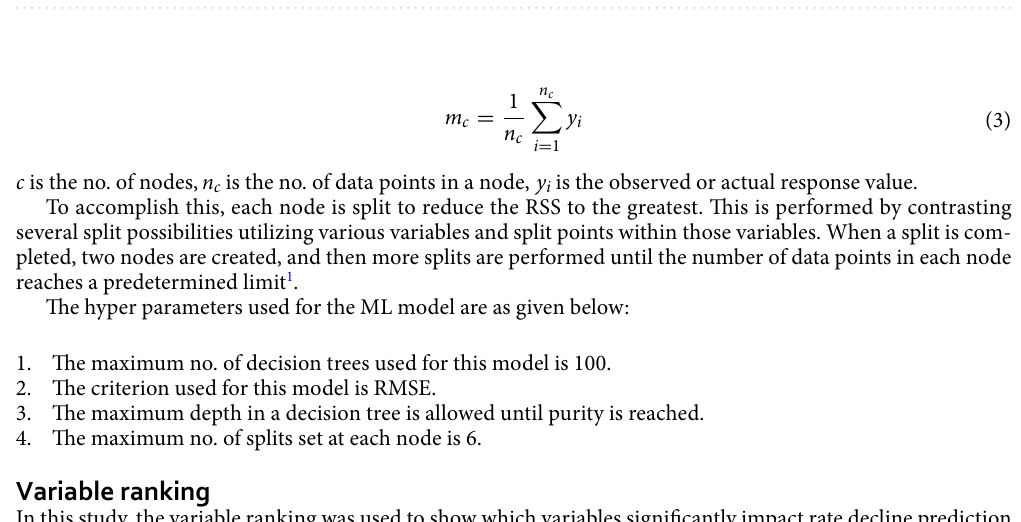
Table 1. Predictor variables ranking by the two Machine Learning